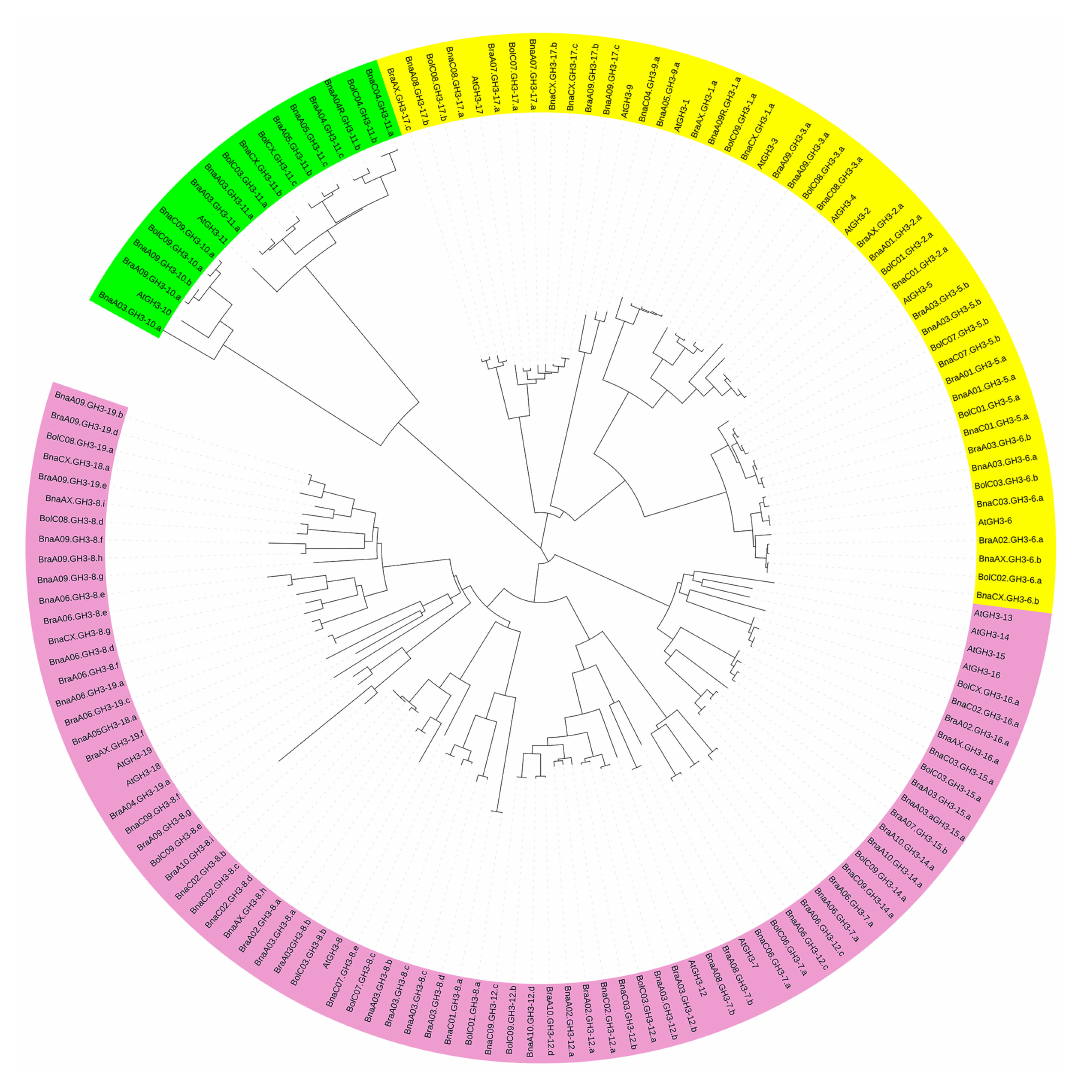
Figure 3. The phylogenetic relationship of GH3 genes among B. rapa , B. oleracea , B. napus , and A. thaliana . The green, yellow, and pink regions represent group I, group II, and group III,